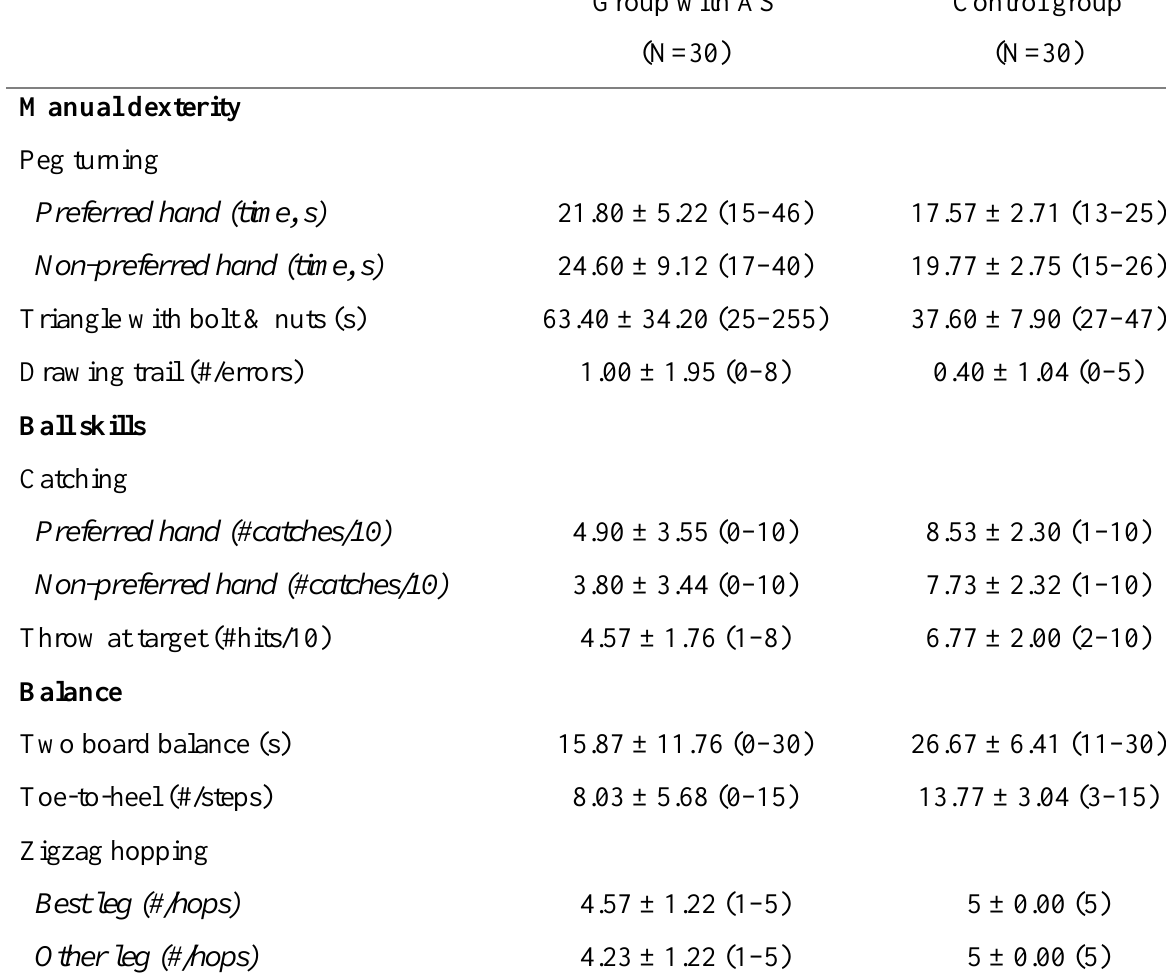
Group means (SD) for manual dexterity, ball skill, and balance tasks of M-ABC-II Group with